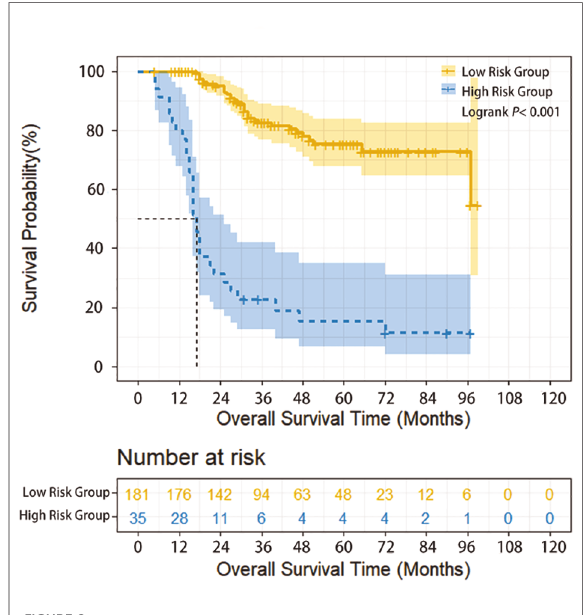
FIGURE 2 Overall survival of ESCC patients with different lymphatic recurrence risk in neoadjuvant treatment subgroup. Overall survival of high-risk patients was signi fi cantly worse compared with low-risk patients in the neoadjuvant treatment subgroup ( P